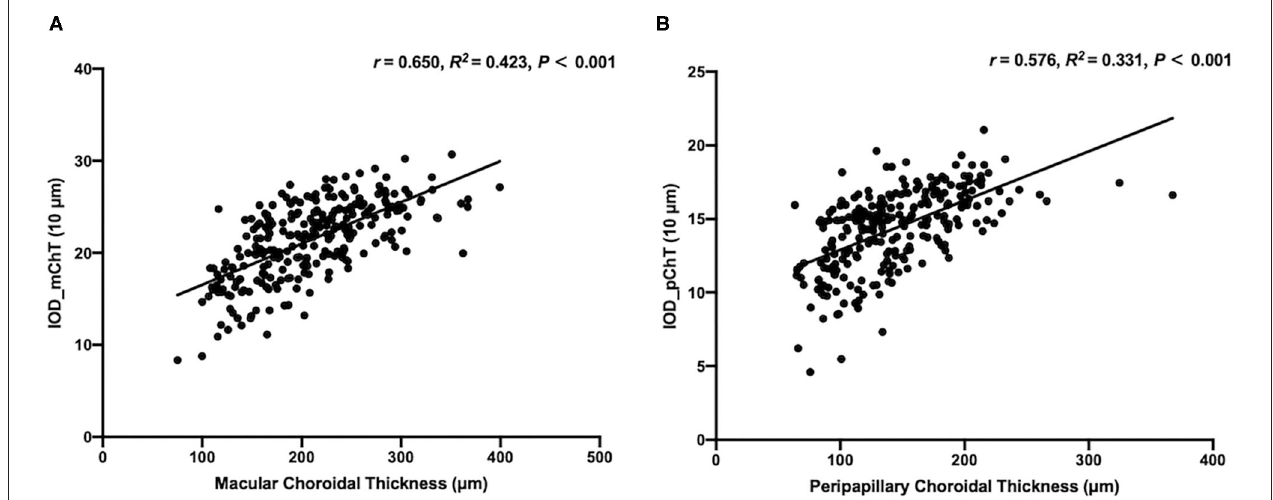
FIGURE 3 | Linear correlation between the macular choroidal thickness (mChT) and the indicator of optic disc for mChT (IOD_mChT) in the test set (A) and linear correlation between the peripapillary choroidal thickness (pChT) and the indicator of optic disc for pChT (IOD_pChT) in the test set (B)